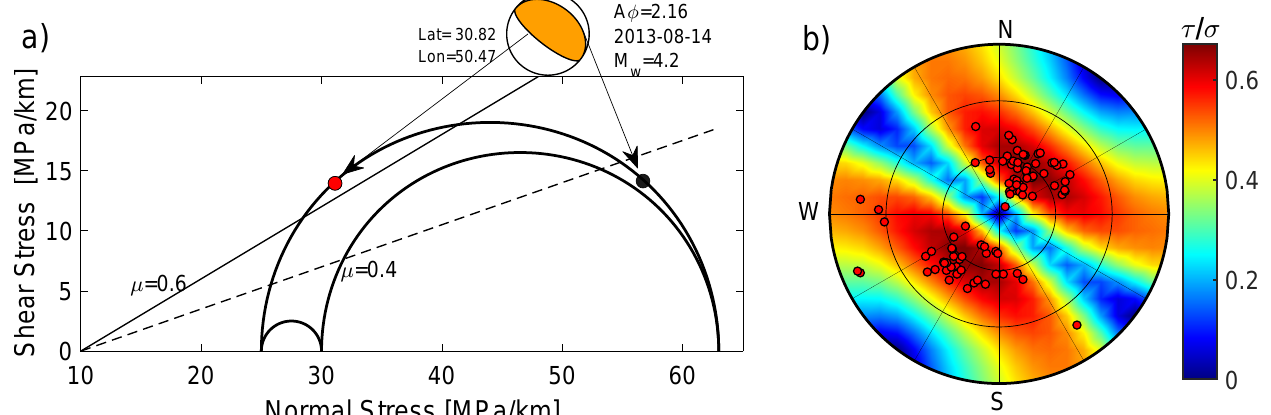
Figure 7. ( a ) 3D Mohr’s circle showing representative reverse focal mechanism and resolved shear and normal stresses for each nodal plane. The color inside the beach ball represents A ϕ = 2.16 and is based on the color bar shown in Figure 6. ( b ) Lower hemisphere stereonet plot of the preferred nodal plane for 92 focal mechanisms in the Dezful Embayment where the state of stress is a thrust-faulting regime. Colors show the ratio of shear to effective normal stresses (required µ ) needed for shear failure on a fault